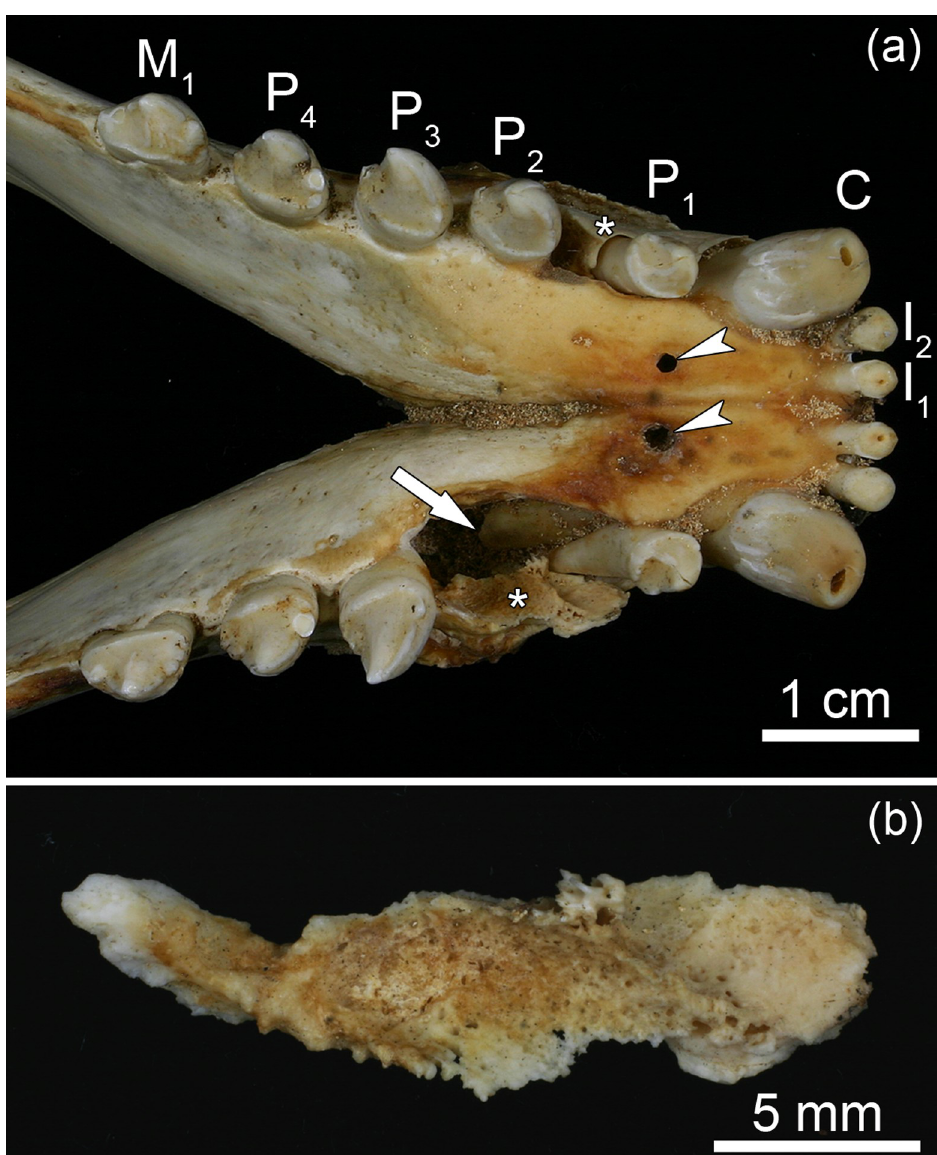
Fig 8. Signs of periapical abscesses and suppurative osteomyelitis in the mandibles of a juvenile Baltic grey seal ( Halichoerus grypus grypus ) from the 19th century (specimen ZMUC 42 4 ). (a) Dorsal view of anterior mandibular region. Note openings into the pulp cavities at the crown tips of both I 1 and both mandibular C, openings of draining tracts (arrowheads), large resorption cavity around the root of the right canine and presence of a large sequestrum in each mandible (asterisks). The loose right P 2 was removed to show the resorption cavity. (b) Completely detached sequestrum that was removed from the right mandible. The surface of the sequestrum shows traces of intense